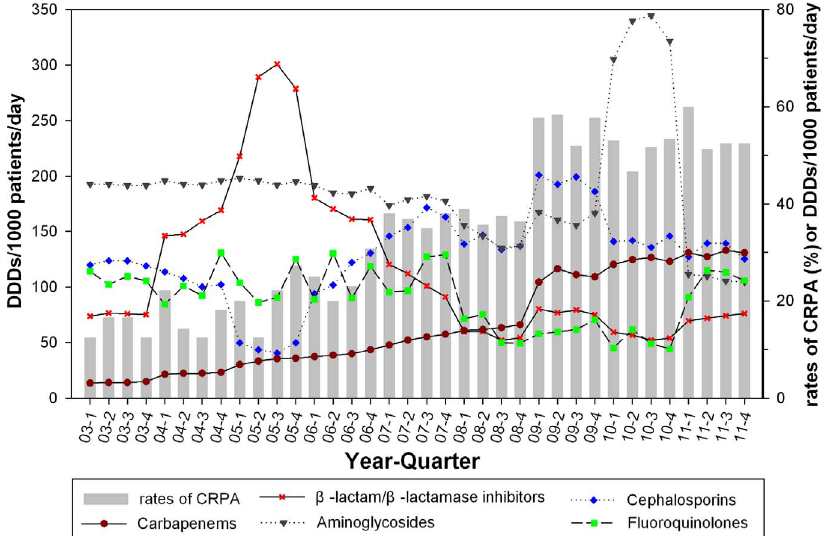
Figure 1. Correlation between quarterly usage of antimicrobial agents and rates of CRPA in First Hospital of Jilin University, 2003– 2011. Consumption of b -lactam/ b -lactamase inhibitors, and cephalosporins is expressed as defined daily dose (DDD) per 1,000 patients-days (DDDs/ 1000 patients/day, left y-axis). Consumption of carbapenems, aminoglycosides, and fluoroquinolones is represented as DDDs/1000 patients/day (right y-axis). The rate of CRPA is calculated by dividing the number of CRPA by the total number of the isolates multiplied by 100 (%, right y-axis). ARIMA models demonstrated that quarterly CRPA was strongly correlated at one time lag with quarterly use of anti-pseudomonal carbapenems. ARIMA models with cross-correlation consideration were used to determine the relationships between the rates of CRPA and quarterly antimicrobial usage over time by taking into account one time lag (delay for observing an effect of antimicrobial use).